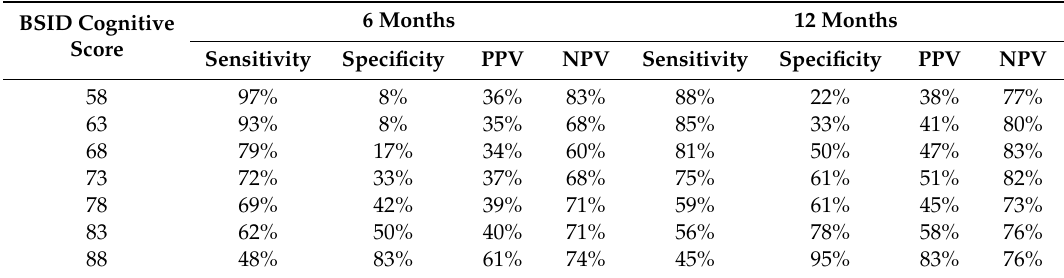
Table 5. Sensitivity, Specificity, positive predictive values (PPV), and negative predicting values (NPV) of the BSID Cognitive score at six and 12 months predicting ASD at 24